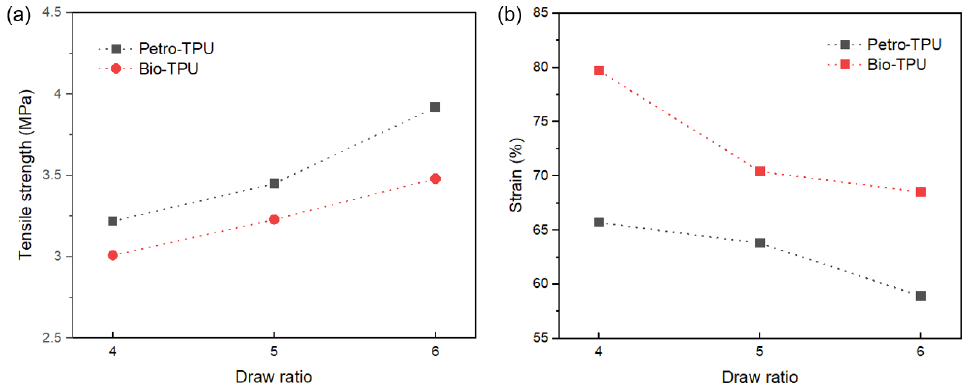
Figure 4. ( a ) Tenacity and ( b ) Strain of Petro-TPU and Bio-TPU according to draw ratios. Table 5. Tensile strength, elongation at break, and elastic recovery according to draw ratio (4, 5, and 6 times) of Petro-TPU and Bio-TPU.